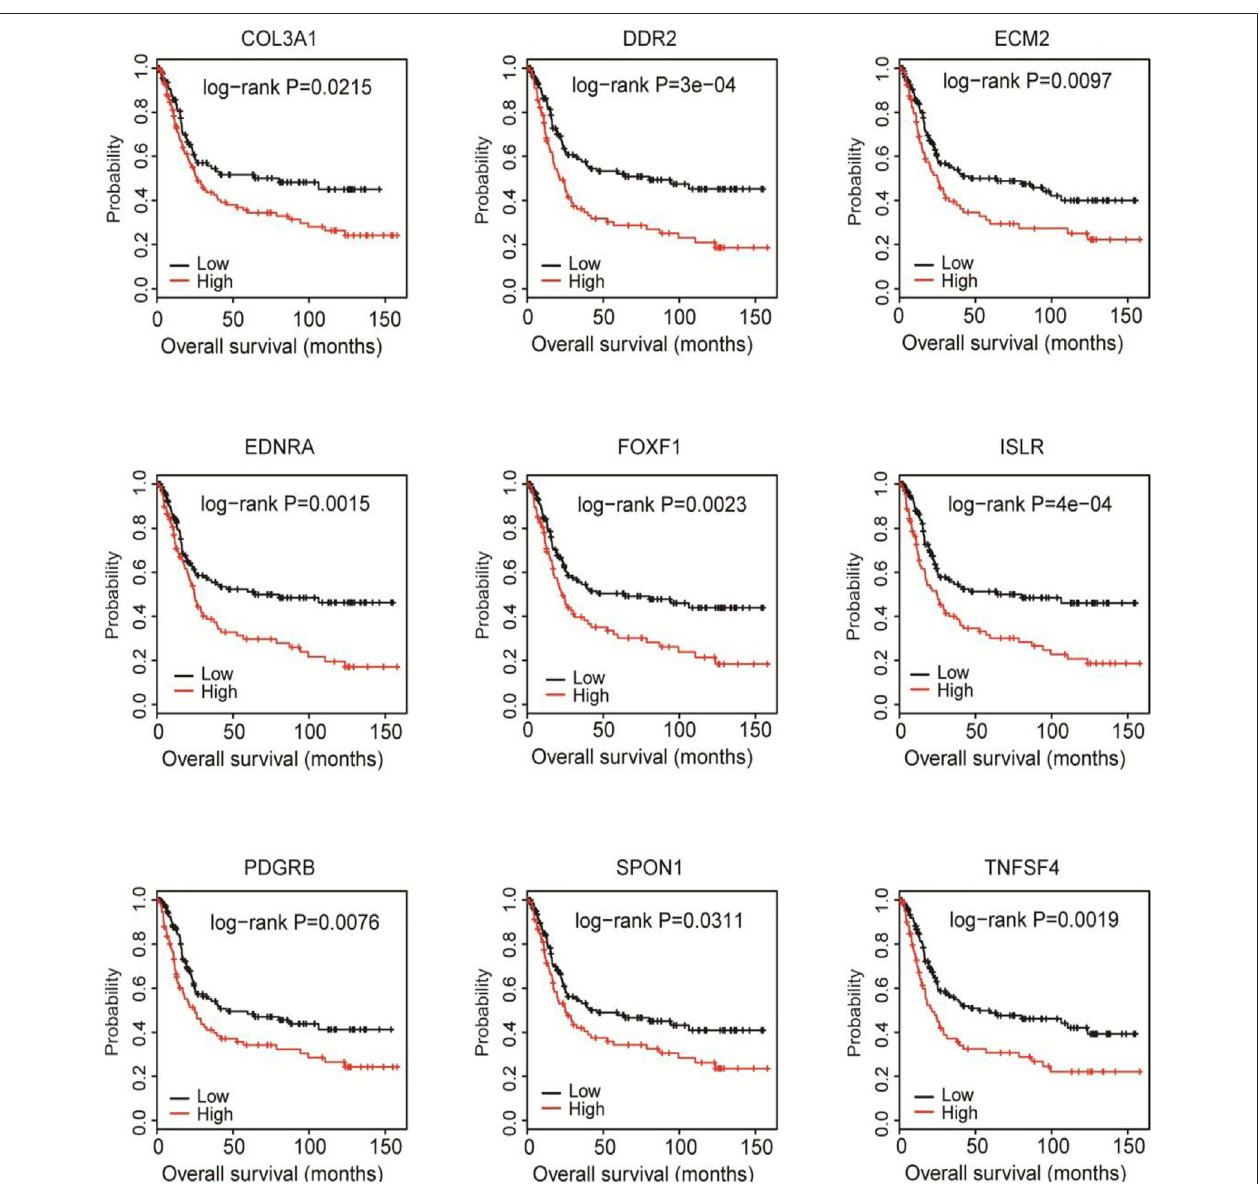
FIGURE 6 | Validation of the prognostic value of the 9 hub genes in the GSE15460 cohort. The GSE15460 dataset was downloaded from the Gene Expression Omnibus (https://www.ncbi.nlm.nih.gov/geo/) as avalidation cohort. Kaplan-Meier survival analysis was performed to examine the associations of9 hub DEGs with the overall survival of the GSE15460